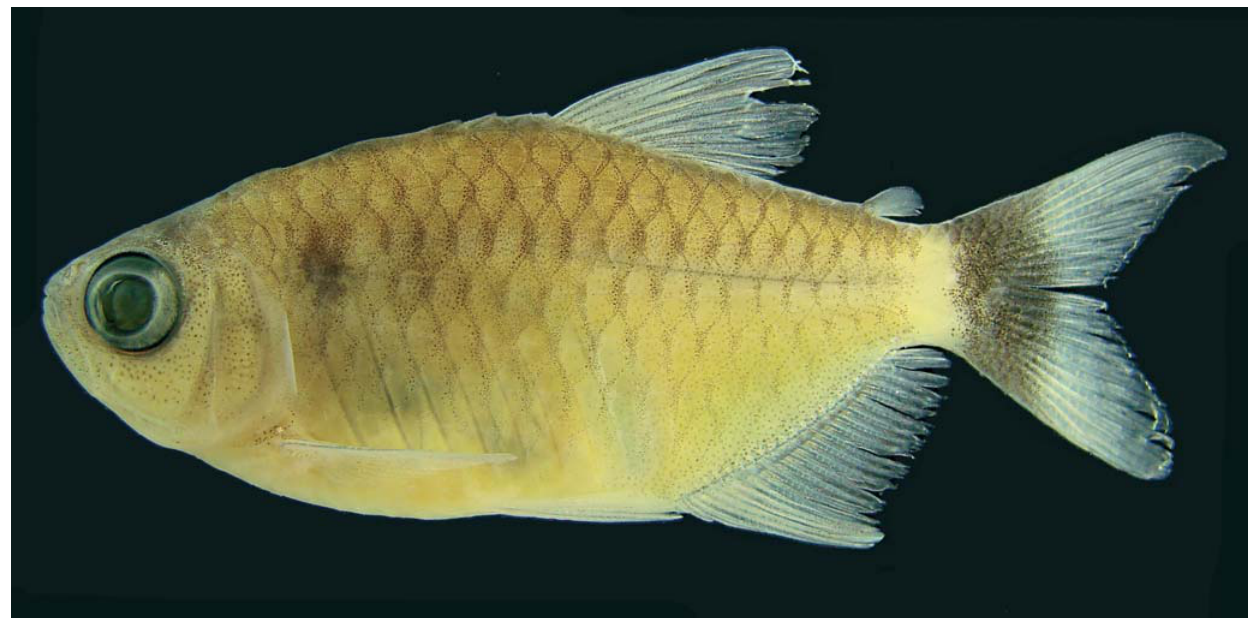
Fig. 1. Moenkhausia forestii , holotype, MZUSP 97827, undetermined sex, 34.0 mm SL, Cáceres, rio Sepotuba, Mato Grosso State, Brazil.